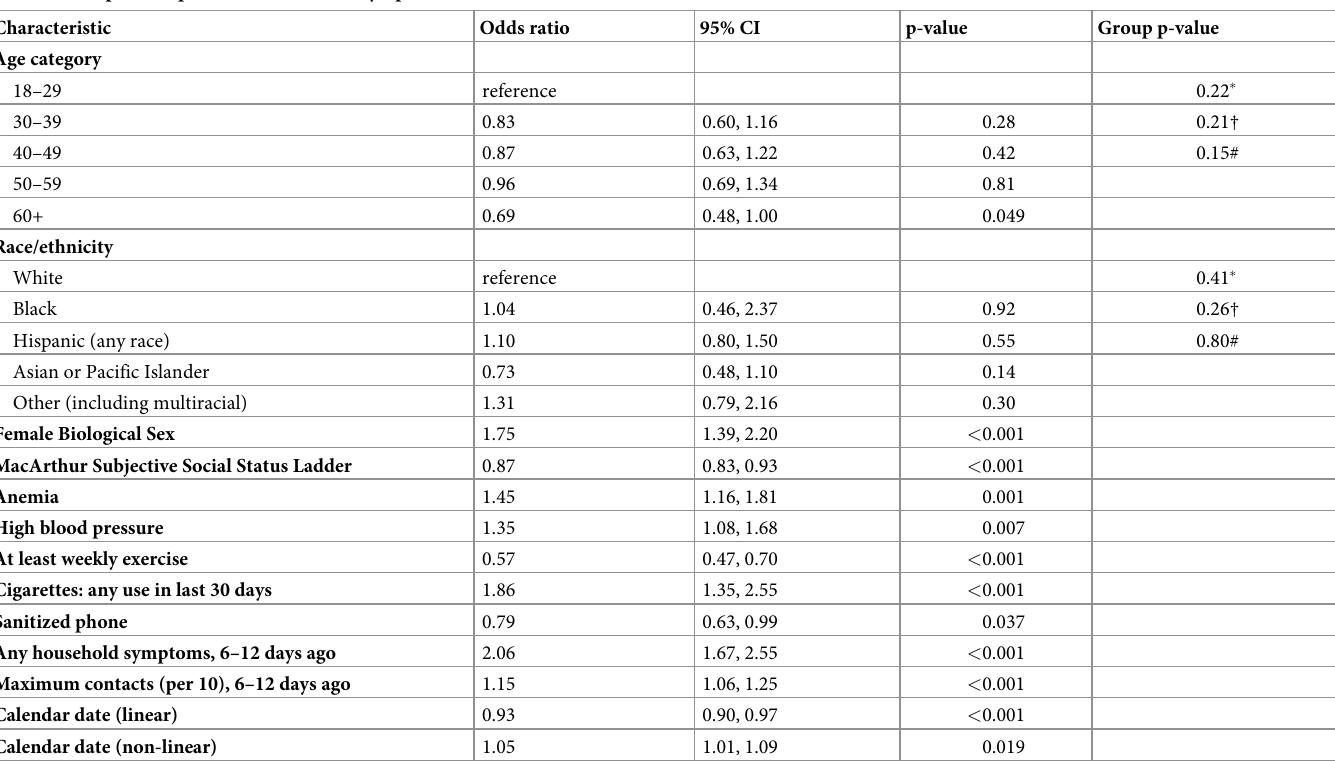
Table 3. Independent predictors of incident